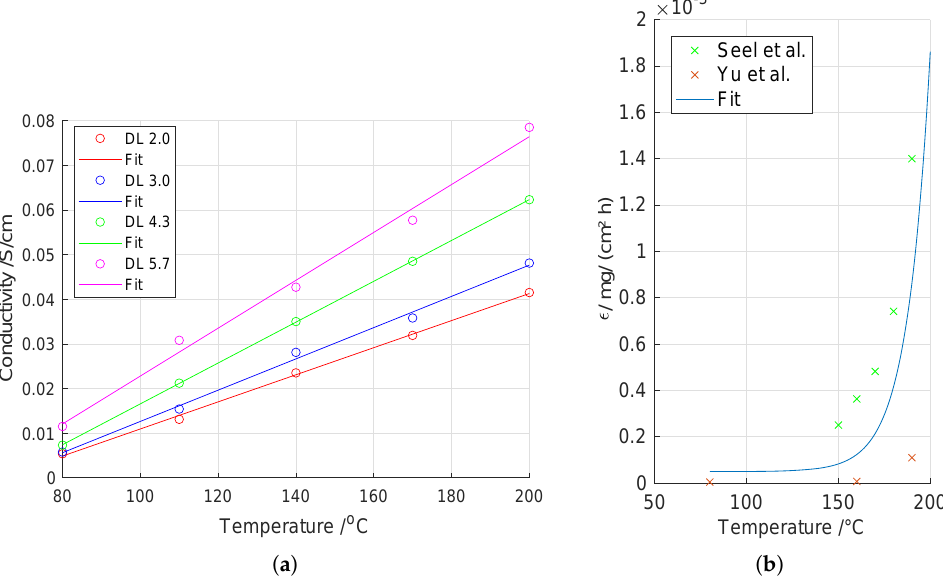
Figure 6. Temperature dependency of ohmic losses over time. ( a ) Conductivity of PBI–H 3 PO 4 at different operating conditions together with fits (recreated from [27]). ( b ) Phosphoric acid evaporation rate as a function of temperature. Data from Seel et al. [58] and Yu et al.